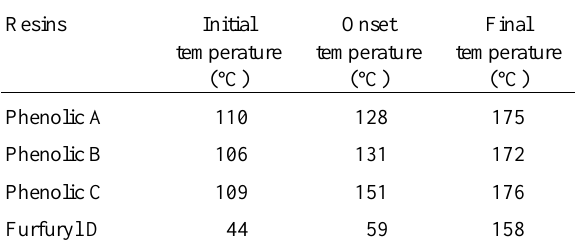
Table 1. DSC results for the phenolic and furfuryl